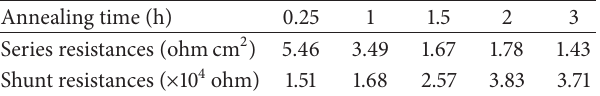
Table2:Shuntandseriesresistancesofdeviceswithperovskitefilms annealed at 105 ∘ C with varying annealing times. Reproduced from [21] with permission from the Royal Society of